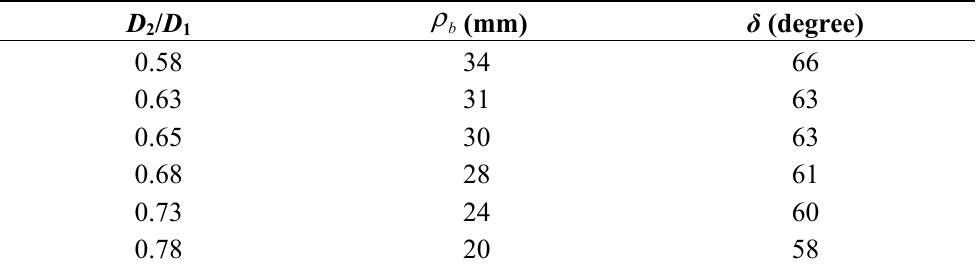
/D for the sensitivity analysis. 2 1